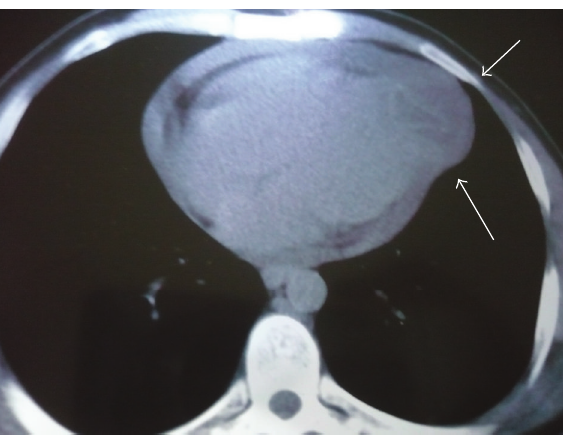
Figure 3: Preoperative contrast thorax CT image.